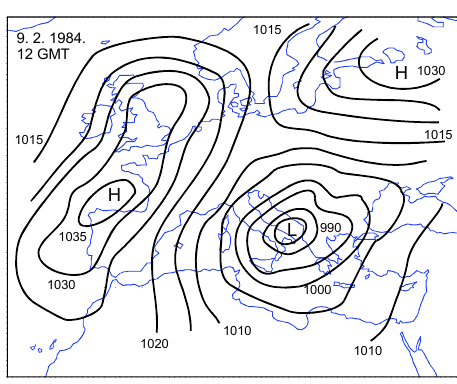
Fig. 6. Surface air pressure field on 9 February 1984.